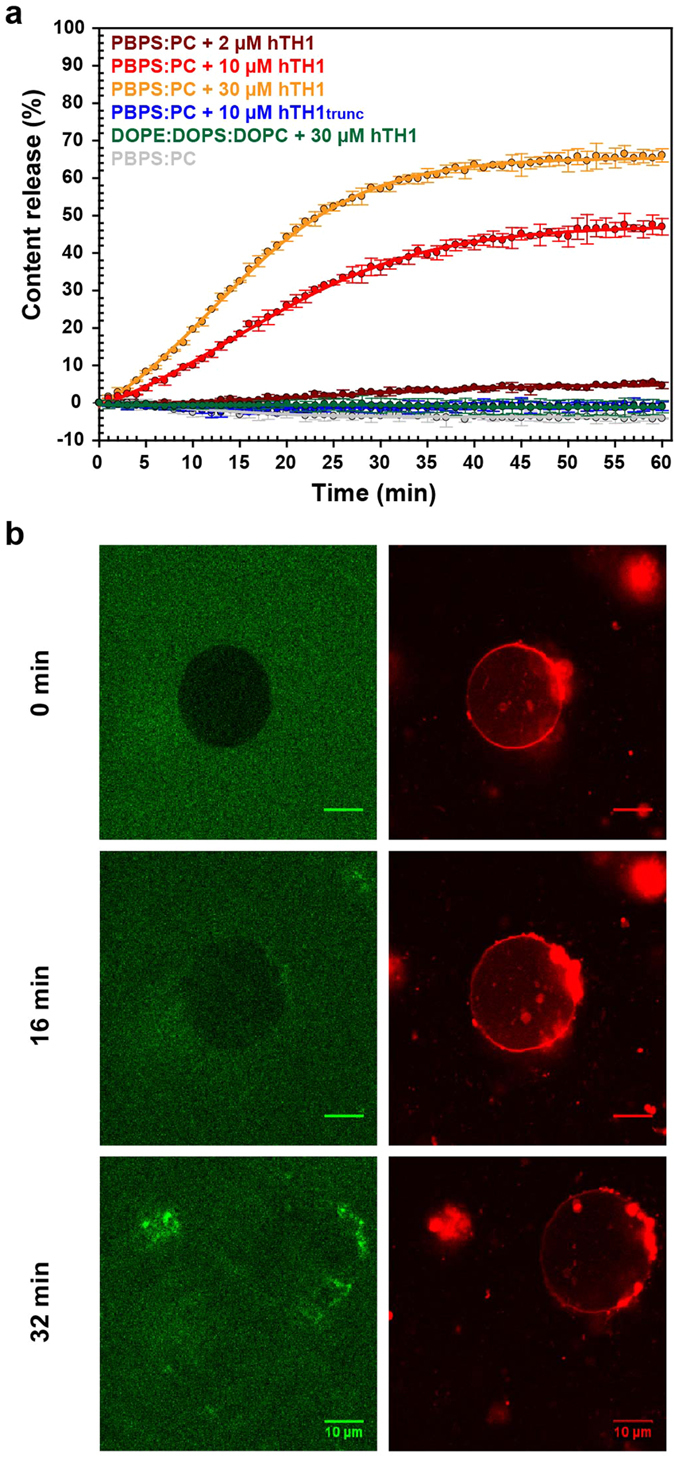
Effect of hTH1 binding on membrane integrity.(a) Disruption of membrane integrity monitored by leakage of fluorophore (ANTS). Vesicle leakage over time at 37 °C in 10 mM Na-Hepes, 150 mM NaCl, pH 7.0 induced by hTH1 at 2 μM (dark red), 10 μM (red) and 30 μM (orange) subunit or 10 μM hTH1trunc (blue) in the presence of PBPS:PC liposomes (0.8 mM phospholipid, pH 7.0). DOPE:DOPS:DOPC liposomes showed no leakage after adding 30 μM hTH1 (green). Buffer controls in the absence of protein (grey) showed no effect on the PBPS:PC membrane integrity over time (same for DOPE:DOPS:DOPC, data not shown). Averaged values (±SD) of three parallel measurements are presented. Curve fitting for hTH1 and hTH1trunc was done by nonlinear regression with equation for a sigmoidal function using 3 or 4 parameters, which provided maximum leakage values (±SE) of 5.8 ± 0.5%, 59.2 ± 1.5% and 80.7 ± 1.3% for 2 μM, 10 μM and 30 μM hTH1, respectively. (b) Confocal microscopy images monitoring the permeation of single unilamellar vesicles. Rhodamine B labelled PBPS:PC GUVs (right column) were embedded in calcein enriched (left column) agarose gel in 10 mM Na-Hepes, 150 mM NaCl, pH 6.0. Membrane permeability was monitored for 32 min after 20 μM hTH1 was added to the chamber. Images at different time points are presented. At 16 min, most of the calcein has entered the GUV while the morphology of the membrane was retained.